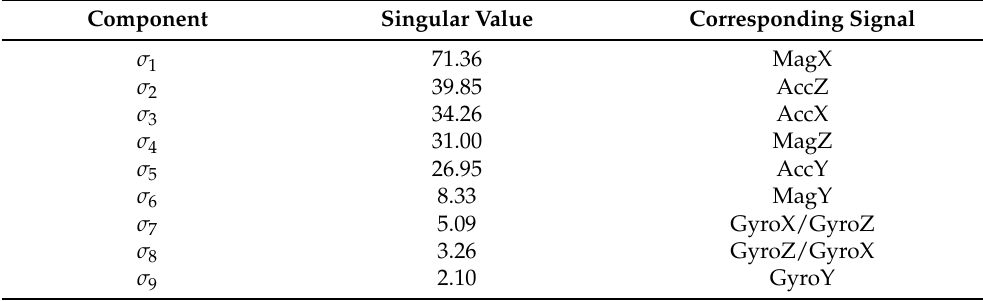
Table A1. Singular values of the re-centered data matrix M in (A1) with the corresponding signals based on the columns of V